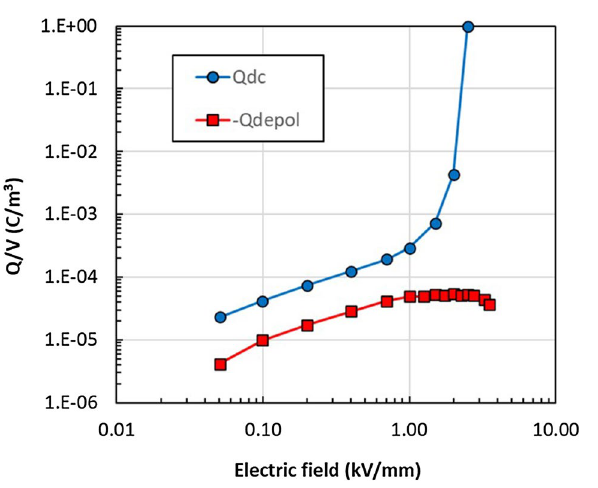
Figure 5. Concentration of mobile charges (Q dc /V) and polarizing charges (Q depol /V) versus electric field at 70